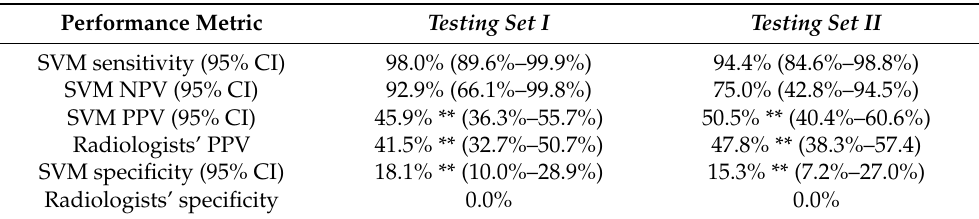
Table 3. Performances of the ensemble of support vector machines in the external testing datasets.